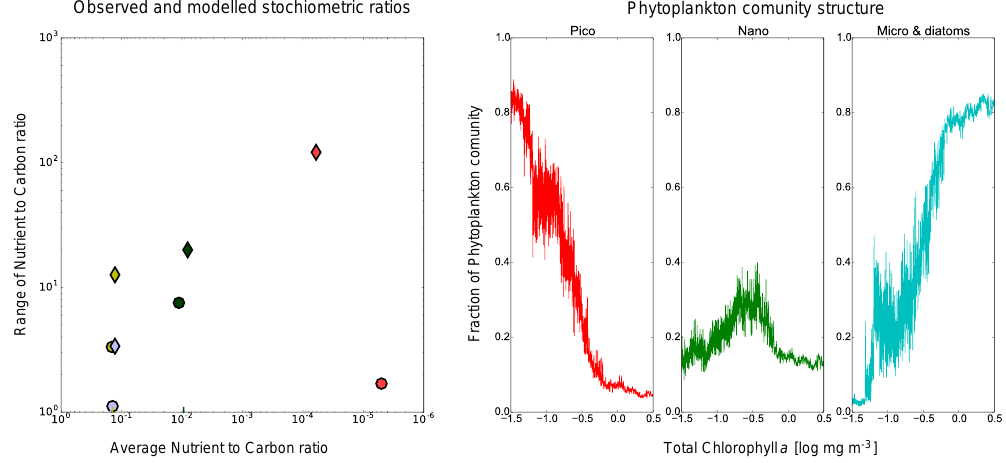
Figure 10. Emergent properties of the simulations across the three one-dimensional sites. Left panel: range (ordinate) and mean (abscissa) of internal stoichiometric ratios of phytoplankton – nitrogen (yellow), silicate (blue), phosphorus (green), and iron (red). Data (diamonds, Moore et al., 2013), assembled one-dimensional model simulations (circles); right panels: community fraction of total chlorophyll a from assembled one-dimensional model simulations. Picophytoplankton (red), nanophytoplankton (green), and microphytoplankton and diatoms